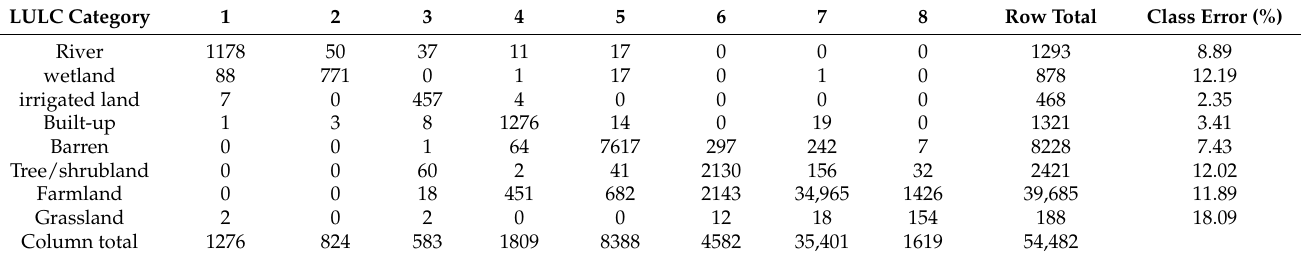
Table 5. Out-of-bag confusion matrix of the Sentinel-1, -2, VH backscatter, and SRTM elevation